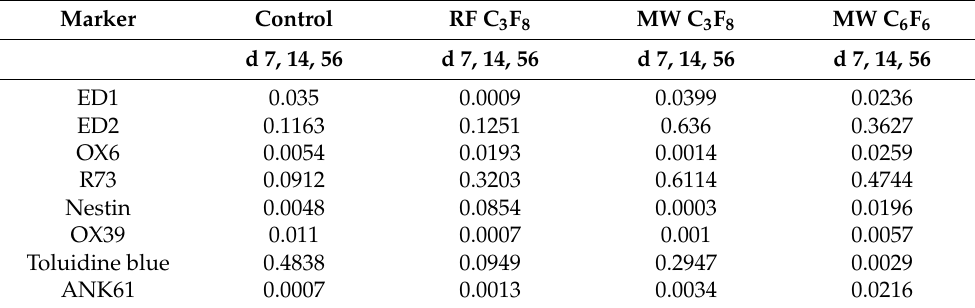
Table 1. Plasma-fluorocarbon-polymer (PFP) film implants p -values; Concerning each marker ED1 (CD68+ monocytes/macrophages), ED2 (CD163+ macrophages), OX6 (MHC class II positive antigen- presenting cells), R73 (T lymphocytes), OX39 (CD25+ (IL-2R+) regulatory T lymphocytes), nestin- positive cells, toluidine blue (mast cells) and ANK61 (NK cells) for comparison of measured per- centages of positively stained area or positive cells per mm 2 in the peri-implant tissue of implant samples, the non-parametric Kruskal–Wallis test with Gaussian approximation was carried out. Marker Control RF C 3 F 8 MW C 3 F 8 MW C 6 F 6 d 7, 14, 56 d 7, 14, 56 d 7, 14, 56 d 7, 14, 56 ED1 0.035 0.0009 0.0399 0.0236 ED2 0.1163 0.1251 0.636 0.3627 OX6 0.0054 0.0193 0.0014 0.0259 R73 0.0912 0.3203 0.6114 0.4744 Nestin 0.0048 0.0854 0.0003 0.0196 OX39 0.011 0.0007 0.001 0.0057 Toluidine blue